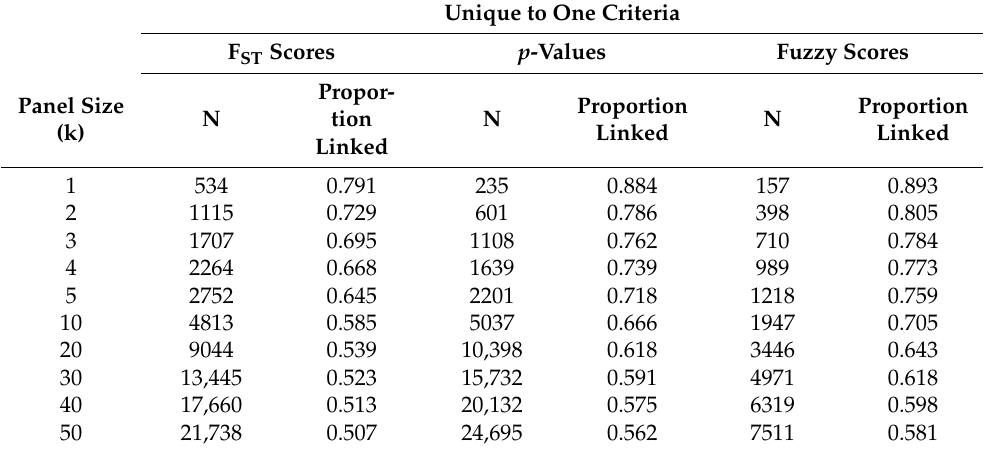
Table 5. The number of unique SNPs and proportion of unique SNPs that are linked with causative variants for F ST score, p -value, and fuzzy score preselection under a genetic architecture of 300 causative